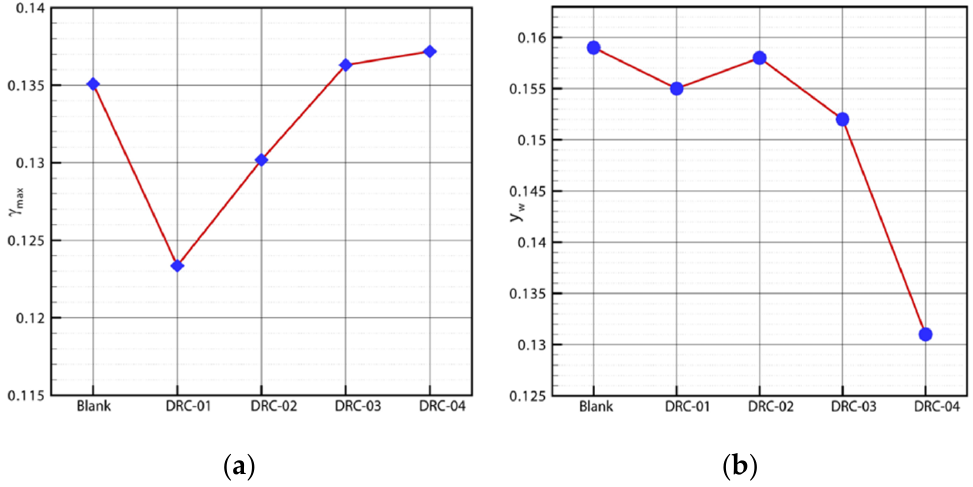
Figure 11. The comparison of maximum total pressure loss coefficient and width of the wake region. ( a ) Maximum total pressure loss coefficient; ( b ) width of the wake region.